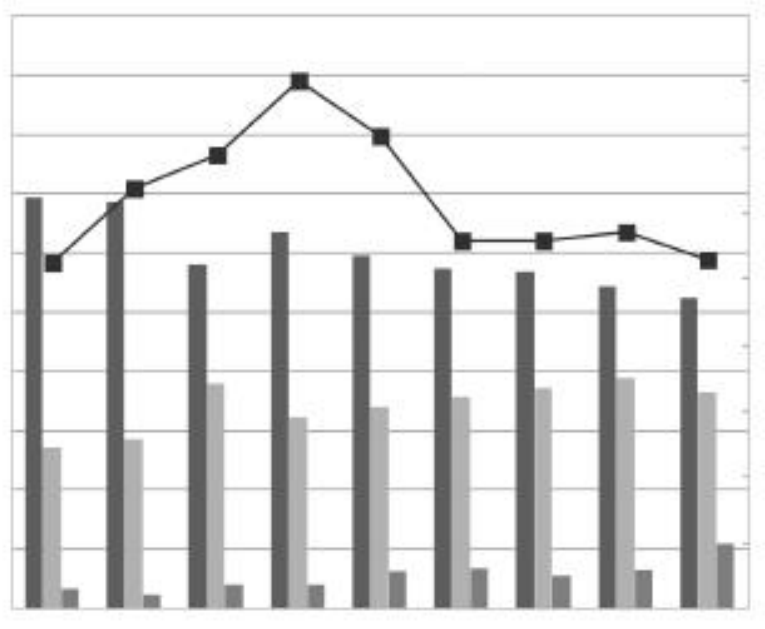
Figura 1. Flussi immigratori registrati al Gaslini negli ultimi 8 anni: le diagnosi sono state divise per